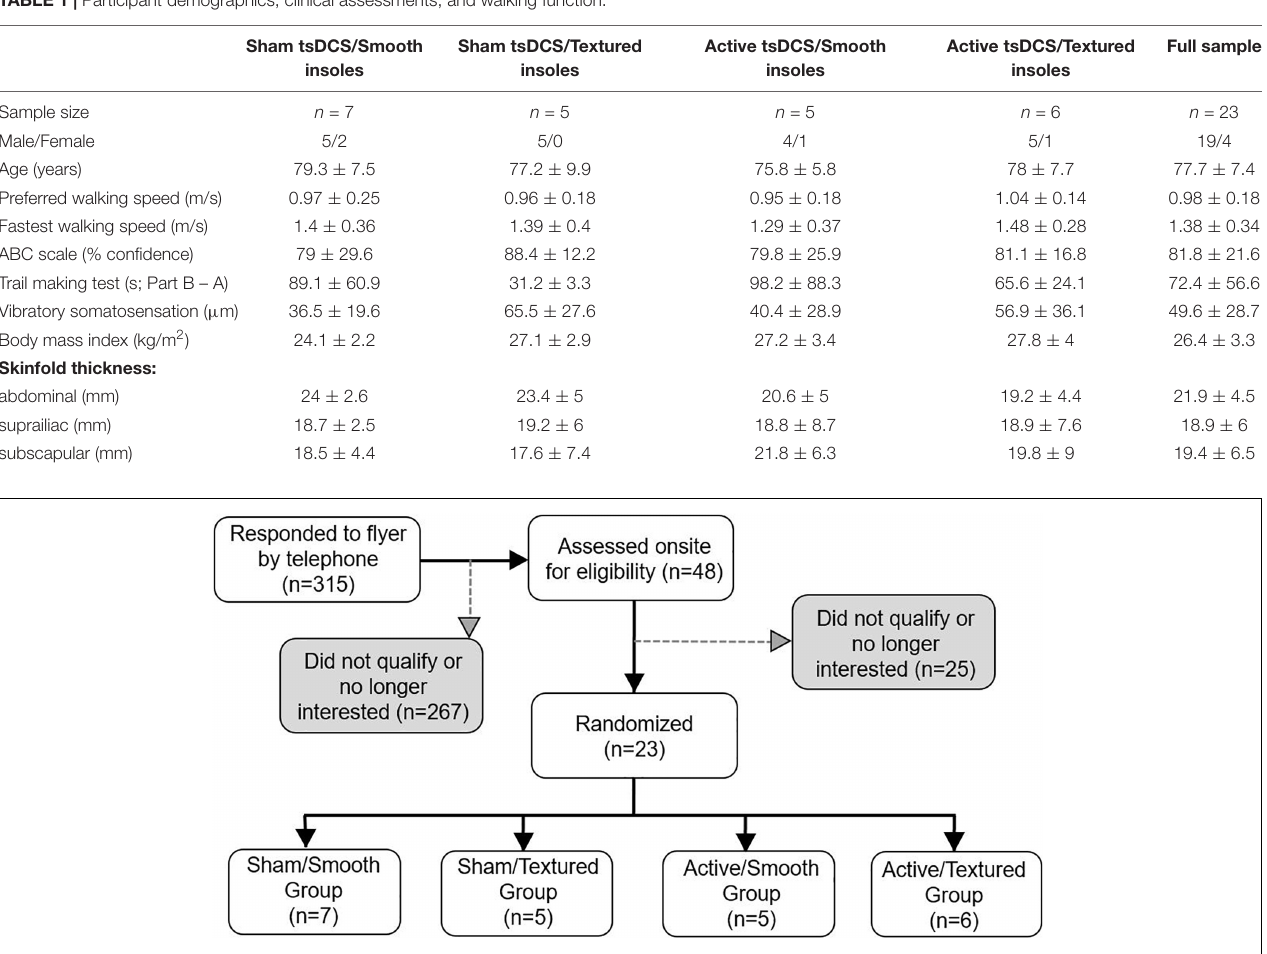
FIGURE 4 | Flow diagram of participant enrollment and randomization. All randomized participants completed the baseline and follow-up visits successfully.